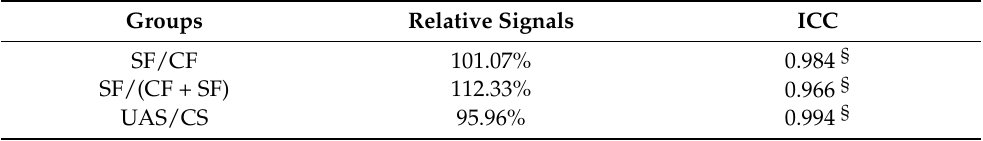
Table 2. Comparison of relative mean uric acid levels and ICC results in real saliva samples with different treatments and assays: treated with CF and SF, treated with SF, and applying both the treatments, and tested by the UAS and CS. Groups Relative Signals ICC SF/CF 101.07% 0.984 § SF/(CF + SF) 112.33% 0.966 § UAS/CS 95.96% 0.994 §